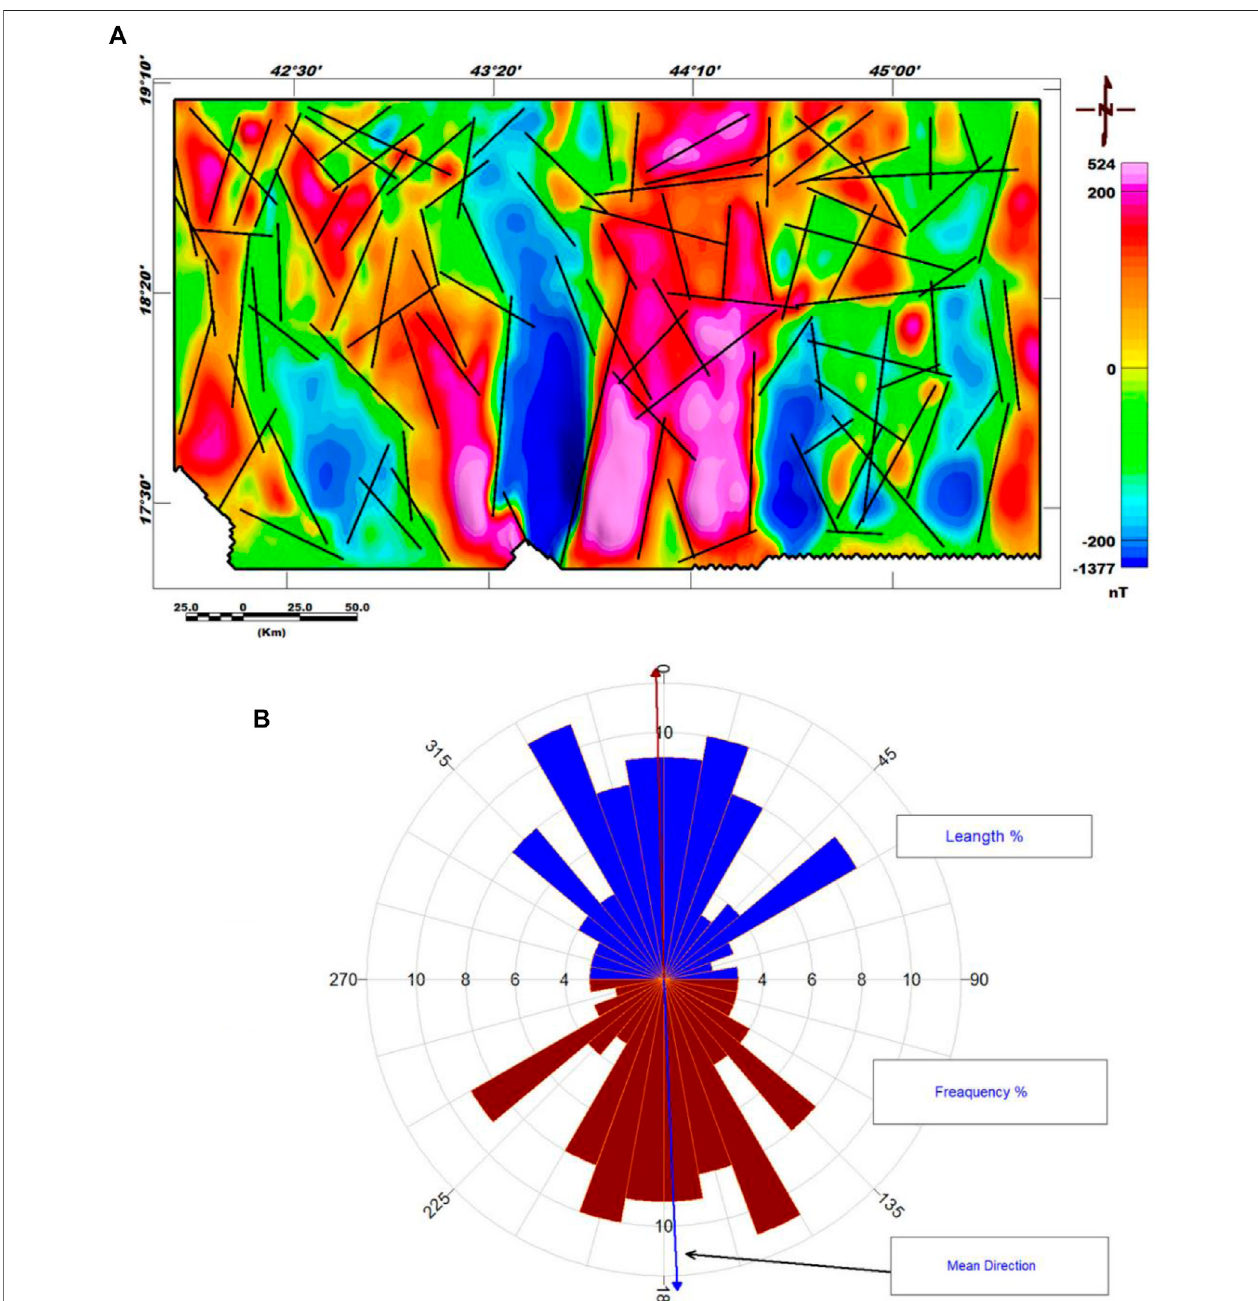
FIGURE 10 | (A) Magnetic lineaments extracted from the RTP map; (B) a rose diagram highlighting the major structural patterns.